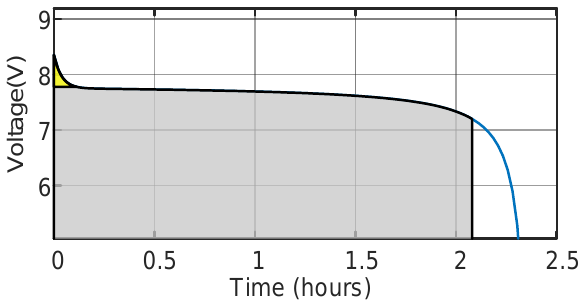
Figure 4. Discharge voltage curve.